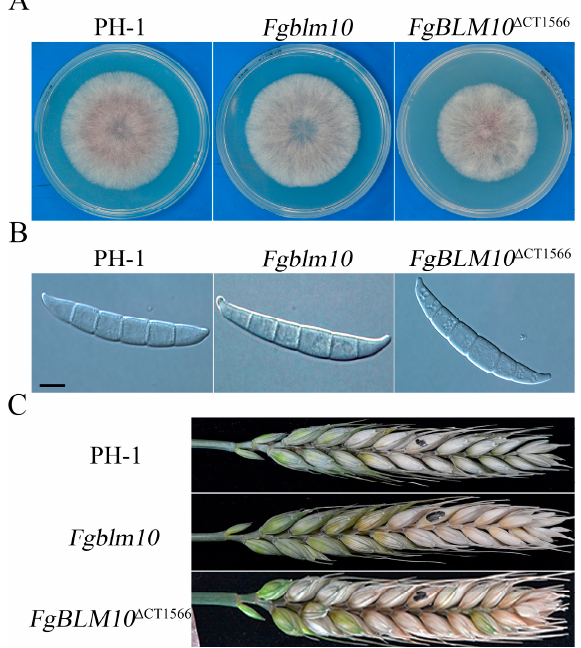
Figure 3. Assays for the phenotypes of the FgBlm10 and FgBlm10 ∆ CT1566 mutants. ( A ) Three-day-old PDA cultures of the wild type (PH-1) and the FgBlm10 and FgBlm10 ∆ CT1566 mutants. ( B ) Conidia from 5-day-old CMC cultures were examined for morphological defects. Bar = 10 µm. ( C ) Wheat heads inoculated with the marked strains were examined for head blight symptoms at 14 dpi. Black dots mark the inoculated spikelets. Table 2. The wild-type and mutant strains of F. graminearum used in this study. Strains